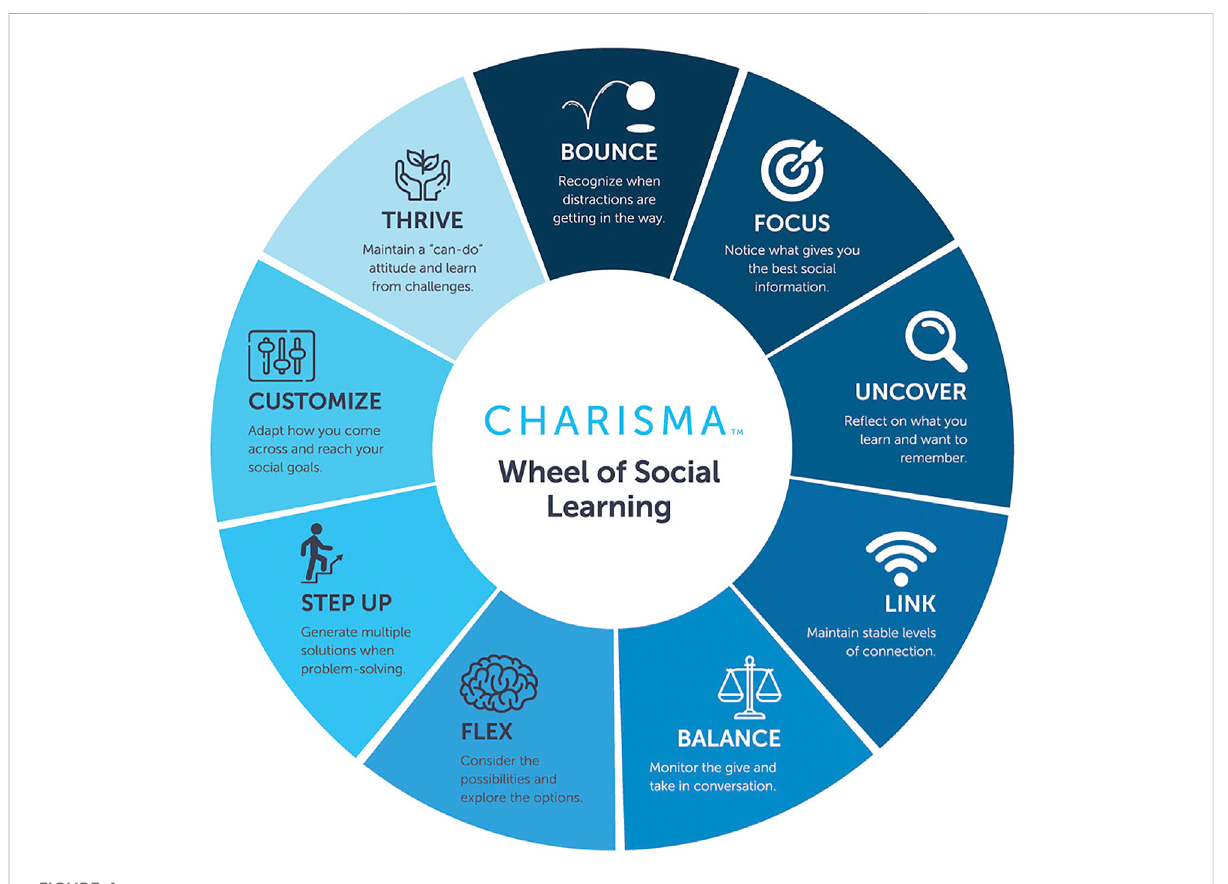
FIGURE 4 Nine core social cognitive strategies were used throughout the